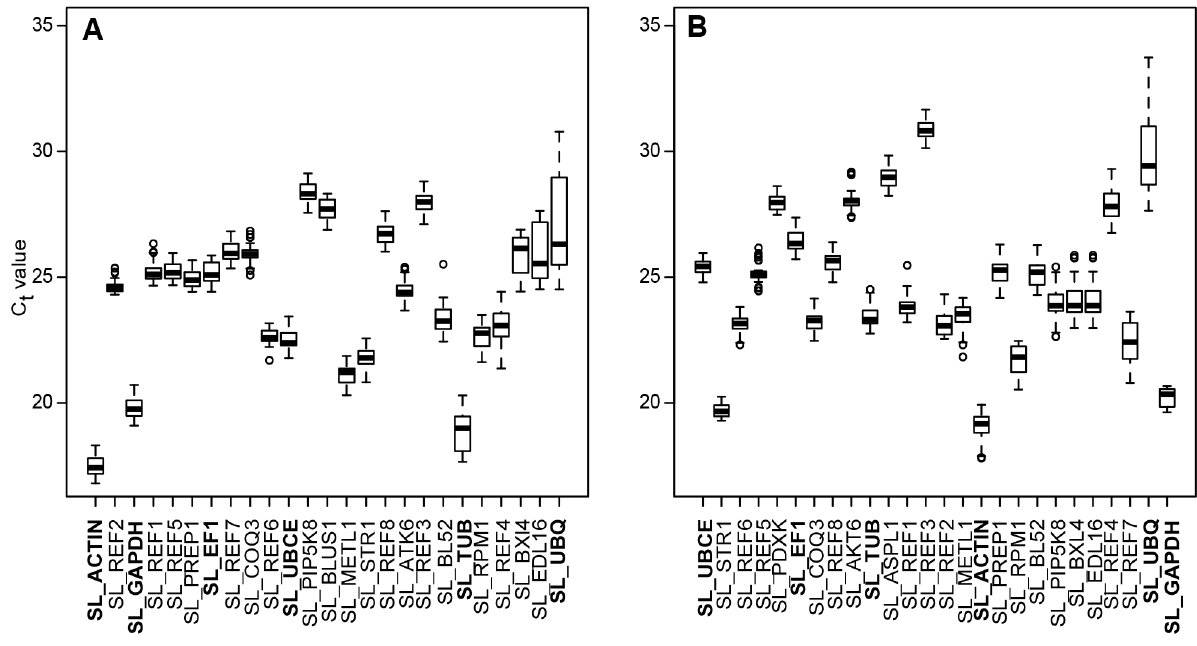
Figure 1. Expression (C t ) values of candidate reference genes ordered by decreasing stability in reproductive and vegetative tissues. Boxplots represent C t values over all tested samples in (A) flower buds (25 genes) and (B) leaves (26 genes) for candidate reference genes that are arranged by decreasing (left to right) stability rank as inferred from RefFinder. Traditional reference genes are indicated in bold.